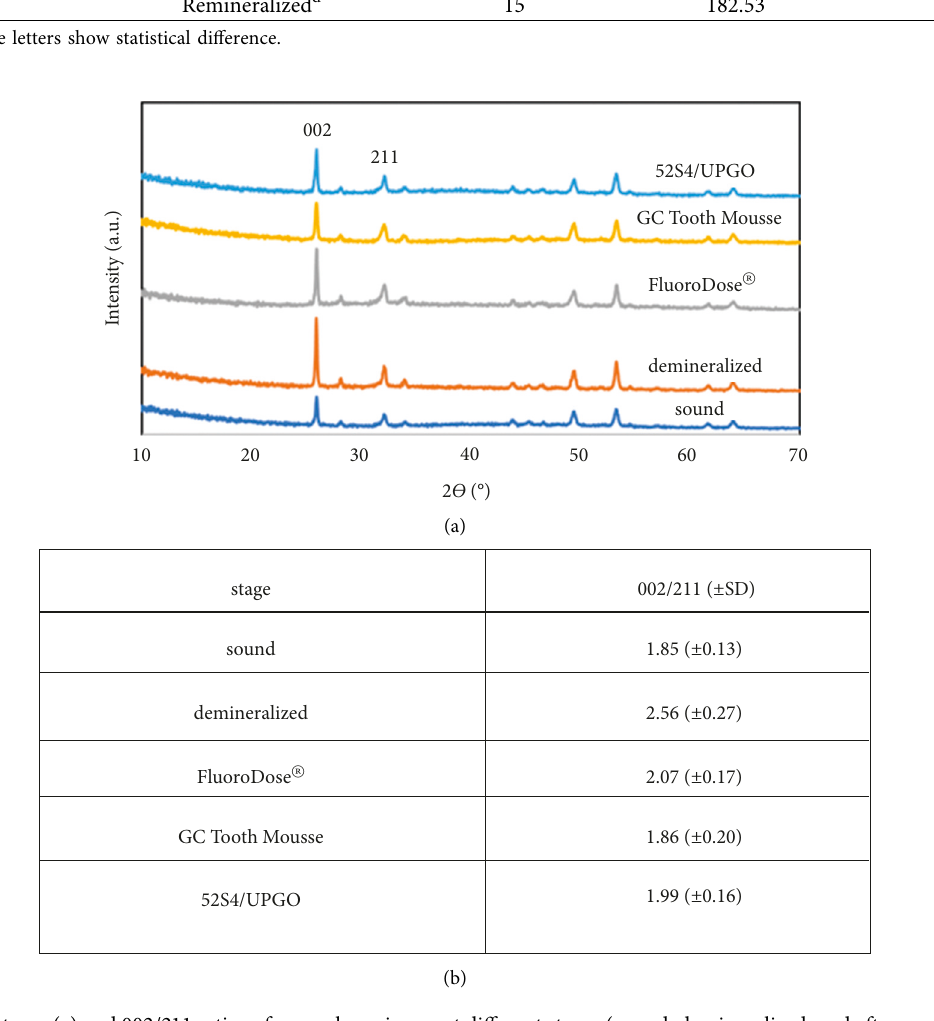
5, SD standard deviation). (cid:30) (cid:30)